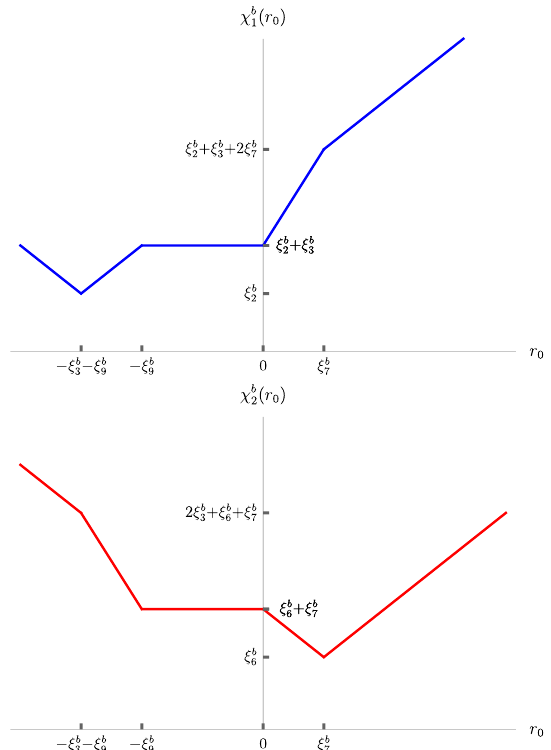
Figure 21: IIA profiles for the vertical reduction of resolution